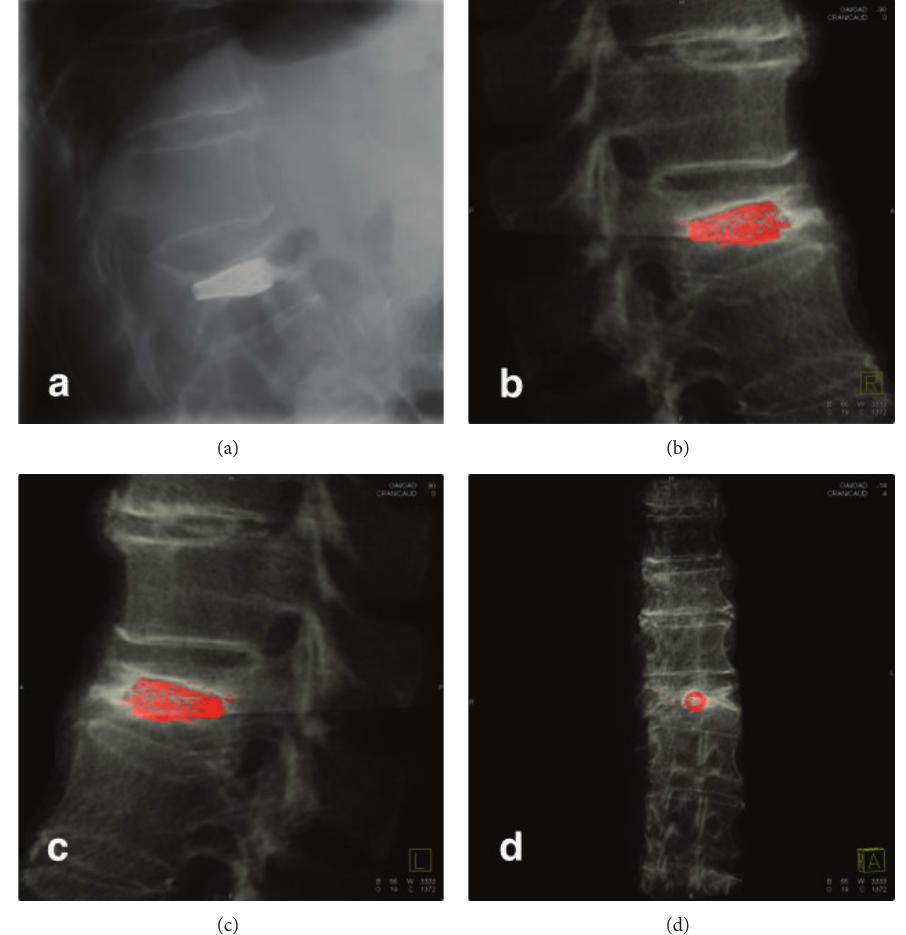
Figure5:Dual-volume3Dreconstructionsinsagittalandcoronalprojections((b),(c),and(d))allowedtheseparaterecognitionofprostheses and vertebrae in all angles. Different magnification of the processed images can be